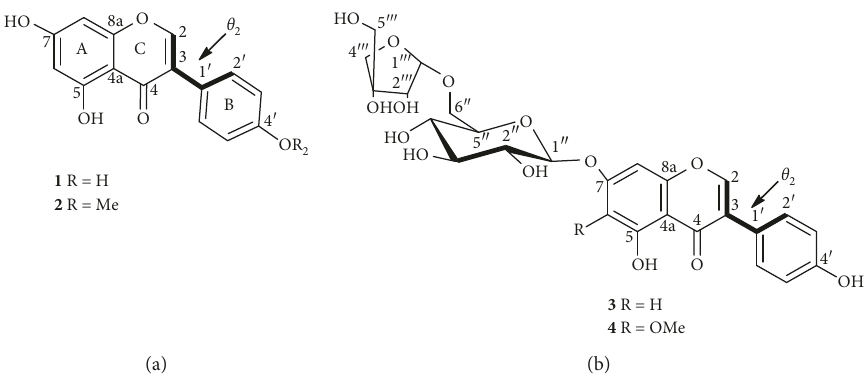
Figure 1: General structures of studied compounds 1–4 with atom